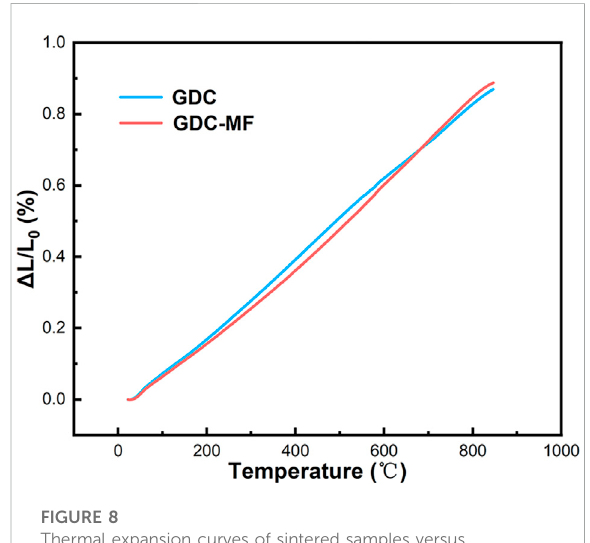
FIGURE 8 Thermal expansion curves of sintered samples versus temperature.